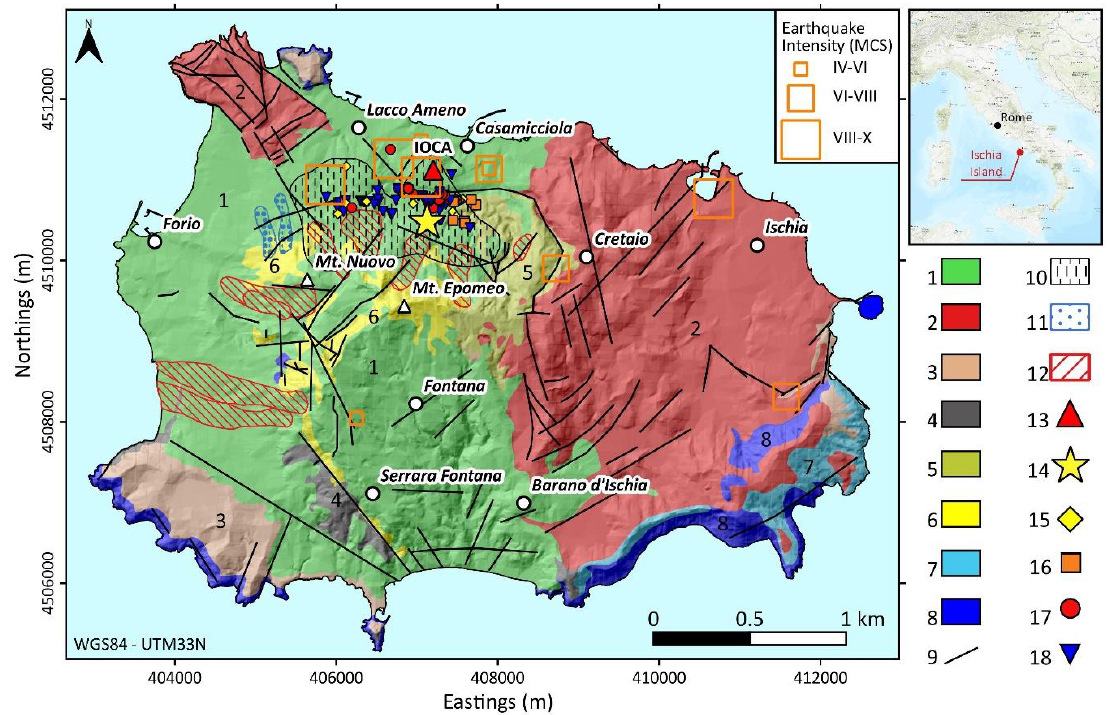
Figure 1. Simplified geological and geomorphological map of Ischia Island (modified from Rapolla et al. [6] and De Vita et al. [7]). Key to the legend: (1) volcaniclastic deposits; (2) volcanics younger than 10 ka; (3) volcanics aged between 28 and 18 ka; (4) volcanics aged between 55 and 33 ka; (5) siltstones and sandstones (Colle Jetto formation); (6) Mt. Epomeo Green Tuff (55 ka); (7) volcanics aged between 75 and 55 ka; (8) volcanics older than 75 ka; (9) main faults; (10) landslide area during the 1883 earthquake [3]; (11) earthquake-induced debris flows and (12) debris slides [3]; (13) IOCA accelerometric station; (14) Ischia earthquake epicenter (http://cnt.rm.ingv.it/); (15) collapse of drywall; (16) coseismic sliding; (17) fractures; (18) ruptures [5]. The orange squares classify the historical seismicity according to their MCS intensity [8].